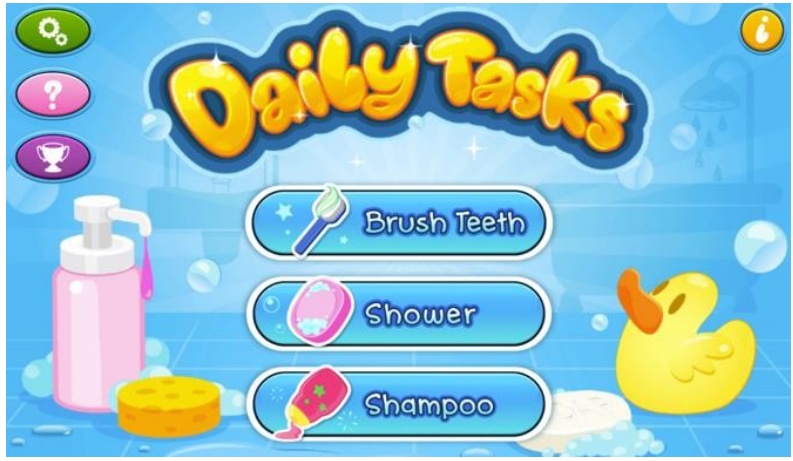
Figure 6. Daily Tasks App